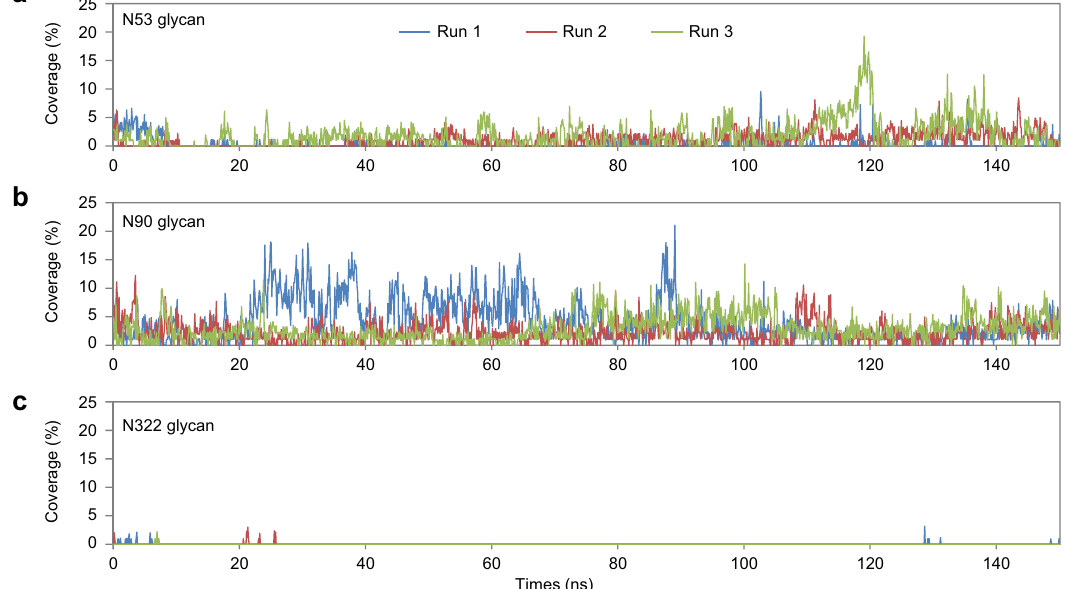
Fig. 7 Coverage of the RBD binding site by ACE2 glycan at N53, N90 and N322. Time trace of the coverage of ACE2 glycans at N53 ( a ), N90 ( b ), and N322 ( c ) with the putative RBD binding site on ACE2 in three simulation